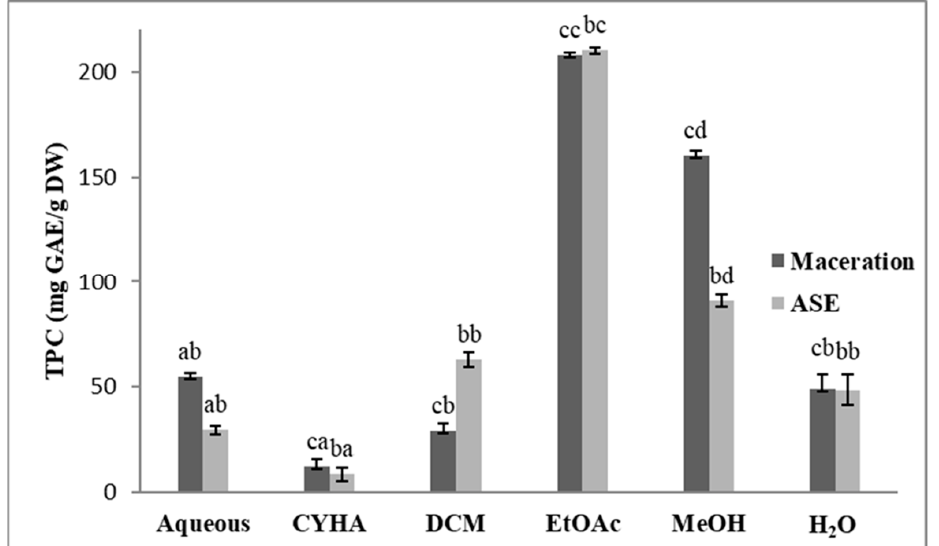
Figure 1. Total phenolic content (TPC) of different extracts of V. vinifera stem (CYHA: Cyclohexane; DCM: Dichloromethane; EtOAc: Ethyl acetate; MeOH: Methanol). Extracts were tested at 50 µg/mL Means values ± SD ( n = 3); Different letter on the histograms means a significant difference ( p ≤ 0.05).